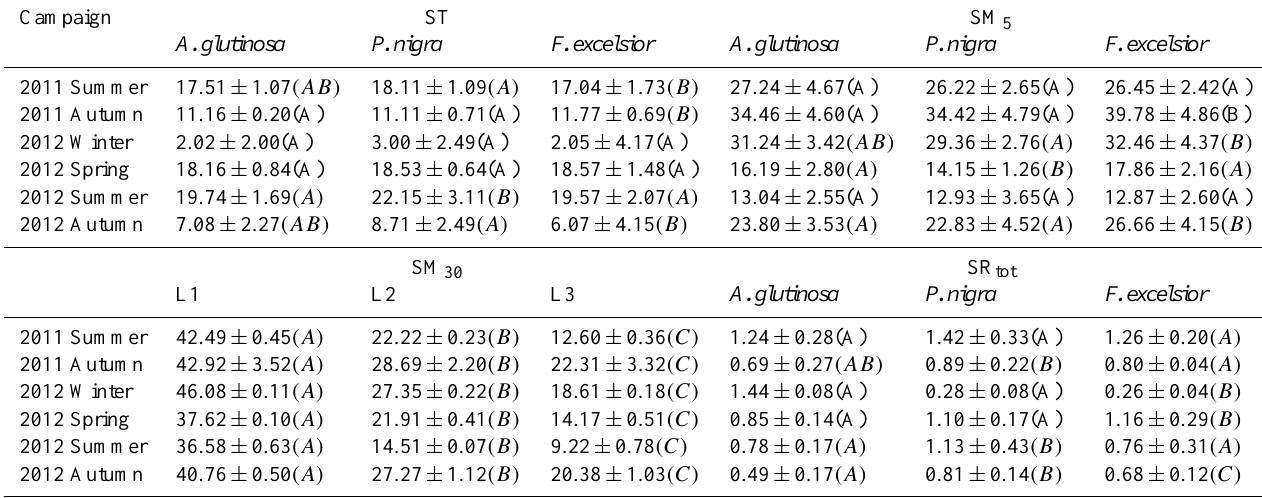
Table B1. Analysis of variance (ANOVA) statistics for soil temperature (ST) and soil moisture (SM): SM 5 , SM 30 , and total soil respiration (SR tot ) of different tree species of the same season. LSD was used to test post hoc. Means with the same letter in parentheses are not significantly different ( P < 0 .